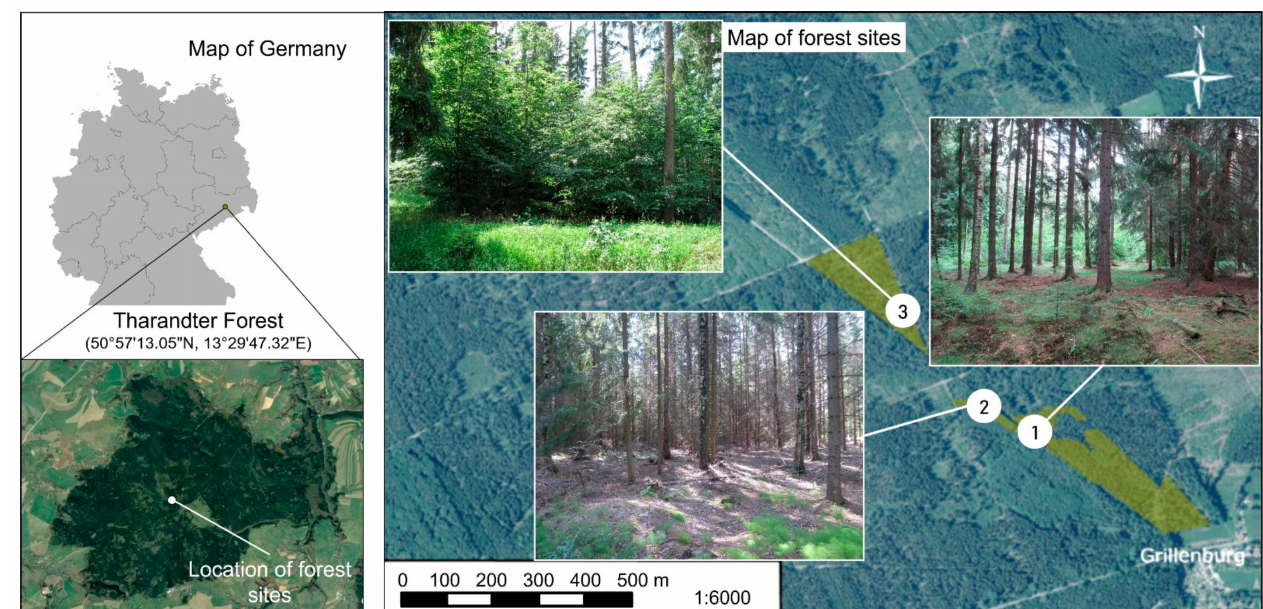
Figure 1. Location and aerial photo of the Tharandter Forest indicating the three viewing window positions superimposed with the corresponding ‘stand pictures’ (Norway spruce forest (1): with regeneration of deciduous tree species in the background, (2): without regeneration, (3): with European beech as a second layer in the